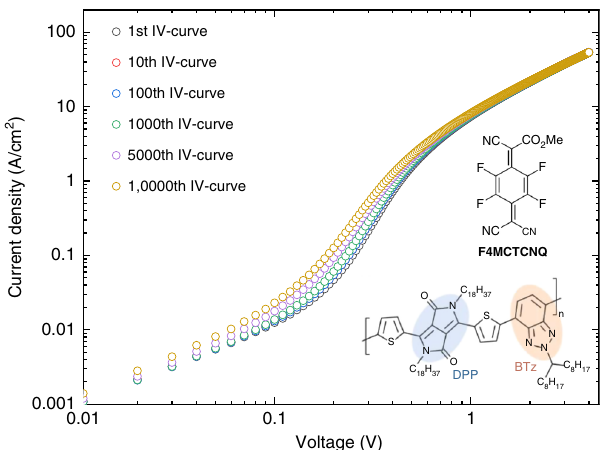
0.01 Fig. 5 Stability of an space charge-limited conduction (SCLC) diode with a solid molecular additive stability of a poly[[2,5-bis(2-octadecyl)-2,3,5,6- tetrahydro-3,6-diketopyrrolo[3,4- c ]pyrrole-1,4-diyl]-alt-(2-octylnonyl)- 2,1,3-benzotriazole] (DPP-BTz) SCLC diode with 2 wt% of the highly soluble solid additive F4MCTCNQ (2,3,5,6-tetra fl uoro-7- methoxycarbonyl,-7,8,8-tricyanoquinodimethane) during 10,000 backward and forward I – V